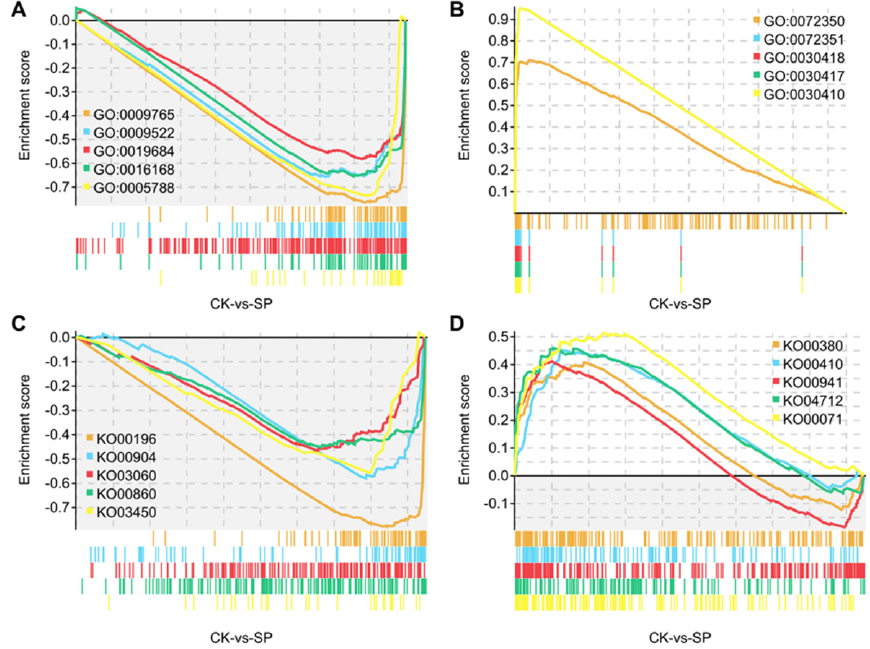
Figure 2. Gene set enrichment analysis (GSEA). Note: GSEA (Gene set enrichment analysis) was performed in the CK vs. SP comparison. ES (enrichment score) reflects the degree of overrepresen- tation at the top or bottom of the ranked list of the genes included in a gene set in a ranked list of all genes present in the RNA-seq dataset. The significantly enriched GO terms with the five lowest and highest NES (normalized enriched score) values (Table S4) were shown in ( A , B ), respectively. That is, ( A ): GO:0009765: photosynthesis, light harvesting; GO:0009522: photosystem I;